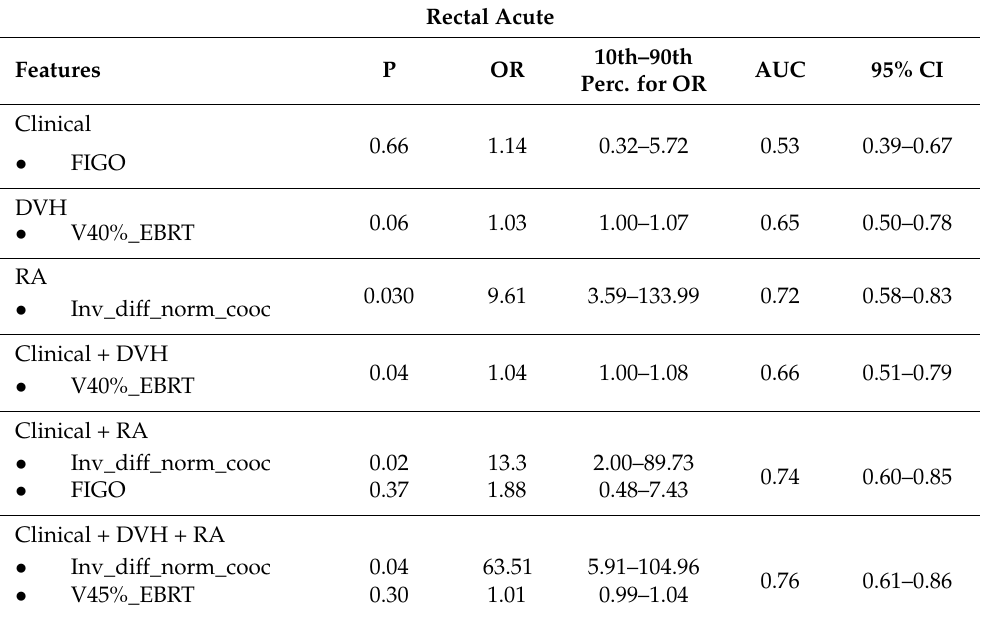
Table 1. Results of the multivariate logistic analysis for acute rectal toxicity.